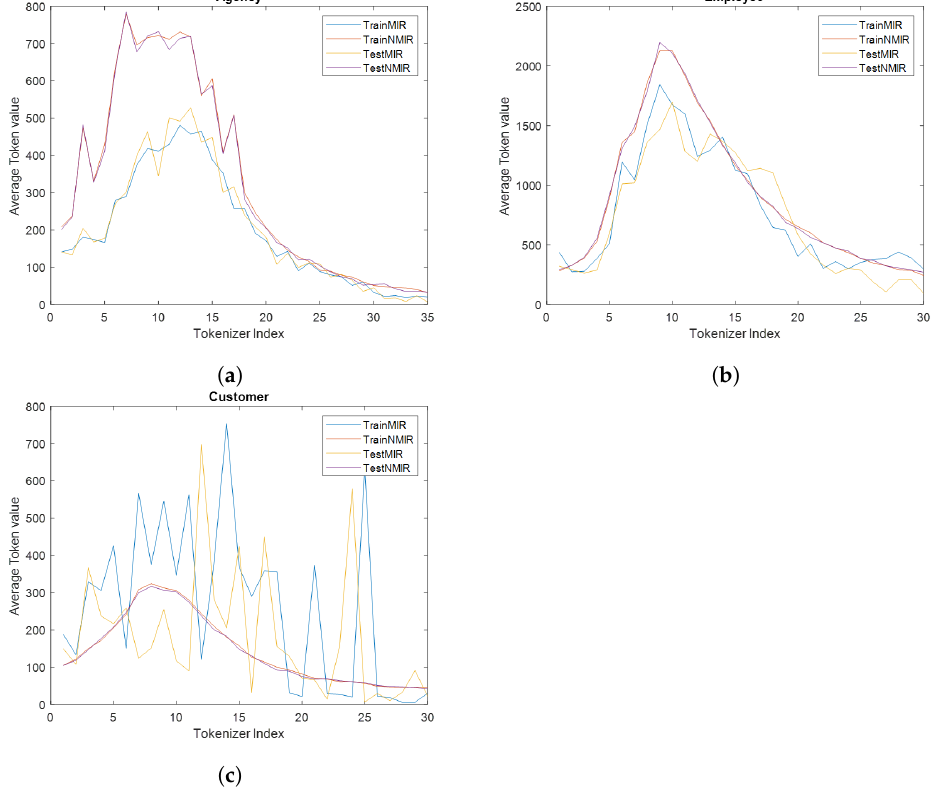
Figure 6. Average tokenizer/class for training and test data across ( a ) Agency_records, ( b ) Em- ployee_records and ( c )